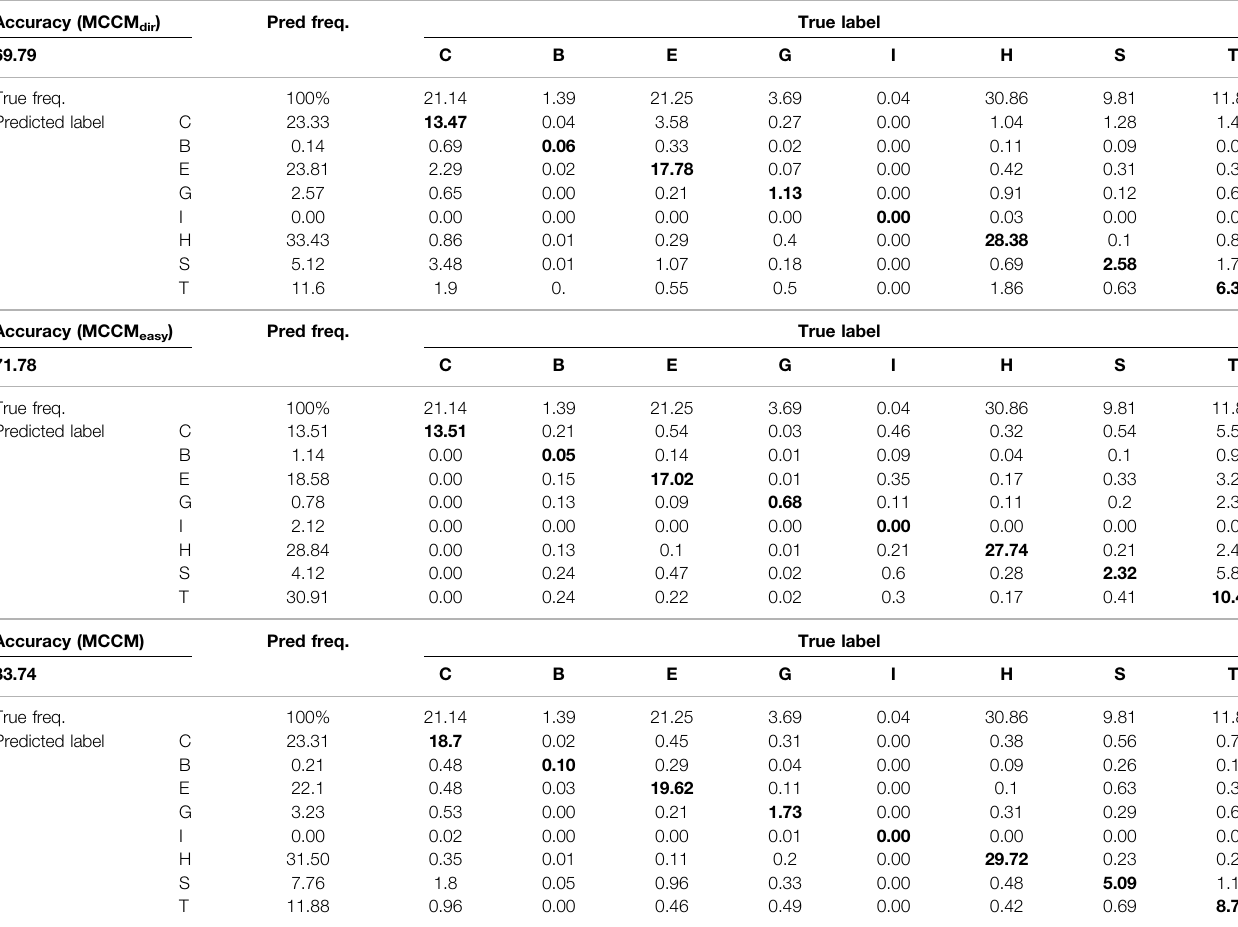
TABLE 5 | Q 8 confusion matrix of 84,765 test labels (MCCM dir , MCCM easy , and MCCM). Accuracy (MCCM dir ) Pred freq.